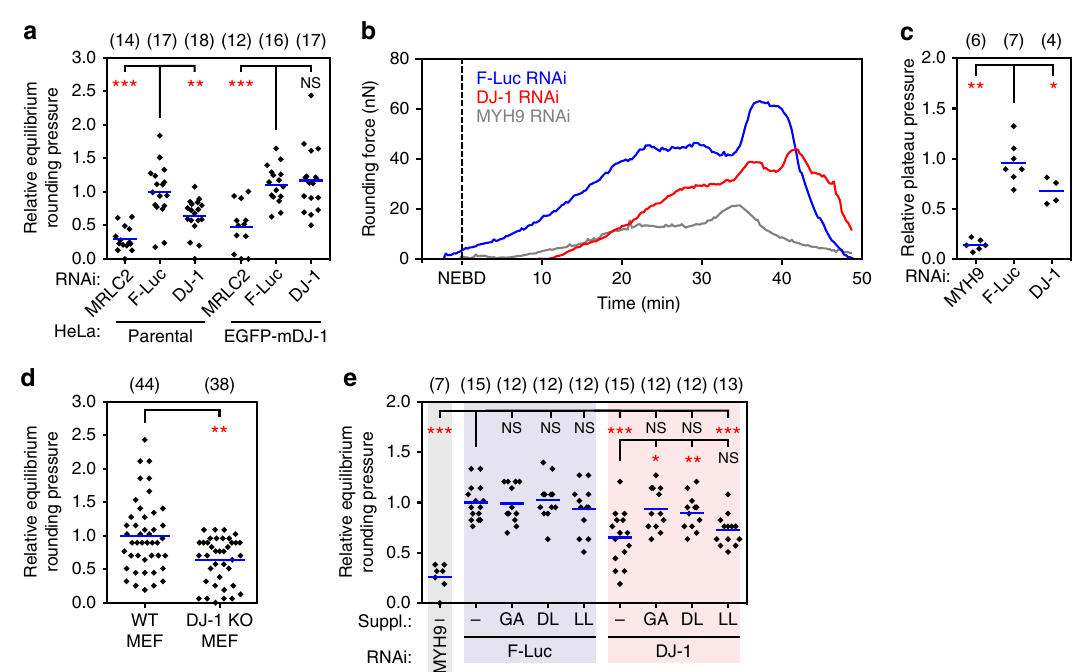
Fig. 5 Glycolate and D -lactate rescue the impaired intracellular pressure of mitotic DJ-1-depleted cells. a Rescue of the decreased mitotic rounding pressure phenotype of HeLa cells by a mouse DJ-1 transgene. HeLa cells were treated with RNAi targeting DJ-1, myosin regulatory light chain (MRLC2) or no human gene ( fi re fl y luciferase control, F-Luc). Rounding pressure relative to average F-Luc control pressure of cells without transgene (parental). b Representative rounding force traces for HeLa cells RNAi treated as indicated (for a depiction of the assay see Fig. 4c). NEBD, nuclear envelope breakdown. c Plateau pressure during metaphase. Values relative to average F-Luc control values. d Rounding pressure of STC-arrested wild type (WT) and DJ-1 knockout (KO) mouse embryonic fi broblasts (MEFs). Rounding pressure relative to average WT MEF pressure. e Enantiomer-speci fi c rescue of the pressure defect caused by DJ-1 knockdown. GA glycolate; DL D -lactate; LL L -lactate. Cells were supplemented with 1 mM of indicated chemicals for 1 h prior to measurements. Values relative to average F-Luc control values. Each black diamond represents one cell. ‘ ( n ) ’ denotes number of cells measured. Blue bars, mean. Statistical signi fi cance was determined by Mann – Whitney U -test (NS, p > 0.05; * p ≤ 0.05; ** p < 0.01; *** p <